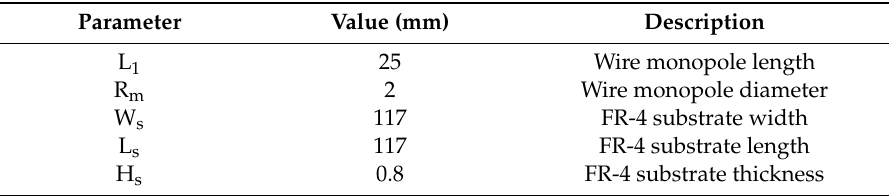
Table 1. Proposed monopole antenna parameters.